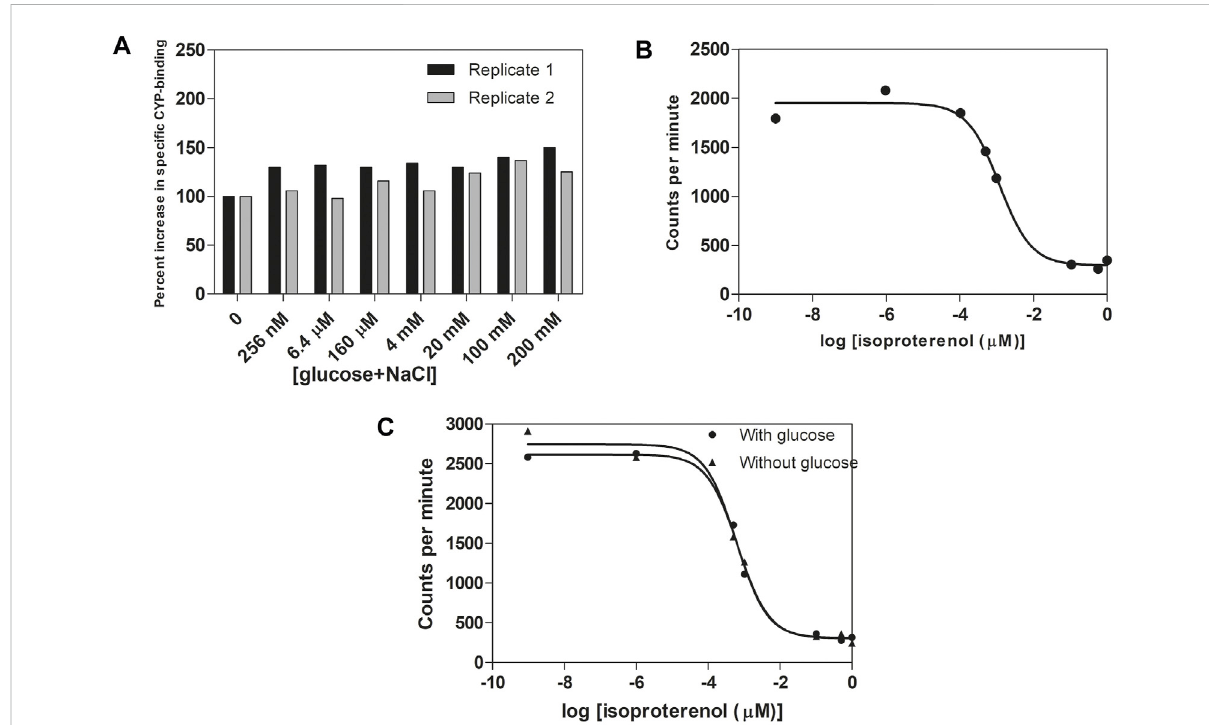
FIGURE 3 Glucose, as opposed to isoproterenol, does not compete with 125 I-cyanopindolol binding to cell-free isolated membrane vesicles containing β 2 -AR. (A) Stimulation of 125 I-cyanopindolol binding with increasing equimolar concentrations of glucose + NaCl (with the total concentration indicated on the X -axis). Two independent replicates were used from separate experiments. Binding in the absence of glucose (2000 – 2,700 cpm) was normalized to 100%. Equal volumes of membrane suspension were used. (B) Inhibition of 125 I-cyanopindolol binding by increasing concentrationsofthe β -ARagonist,isoproterenol.Thelogvaluesat-9and-6representbasalbindingof 125 I-cyanopindolol. (C) Indirectcompetition assay between glucose and isoproterenol for binding of 125 I-cyanopindolol to β 2 -AR. Addition of 100 mM glucose had no signi fi cant effect on the inhibition by any concentration of isoproterenol for 125 I-cyanopindolol binding to β 2